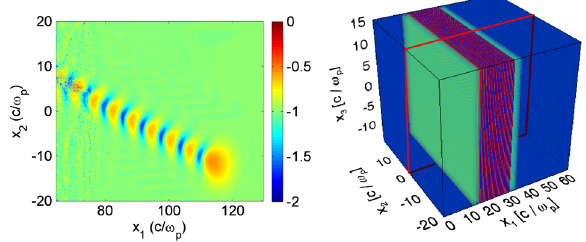
FIG. 2. Illustration of the simulation, taken from the actual results of the simulation. The left picture show the sliced wakefield in the electron density profile at x 3 ¼ 0 . The right picture illustrates the initial electric field profile of the probe pulse. The red line on the right picture shows one of five planes where the slice of the electric field crosses the wakefield at the propagation distance s ¼ 28 μ m after the driver entered the plasma. The axes x 1 , x 2 , and x 3 in this illustration are different from the axes x , y , z in the previous figure where in this illustration the laser probe pulse propagate parallel with x 1 -axis. While in Fig. 1, the probe pulse propagates not parallel to any axis.